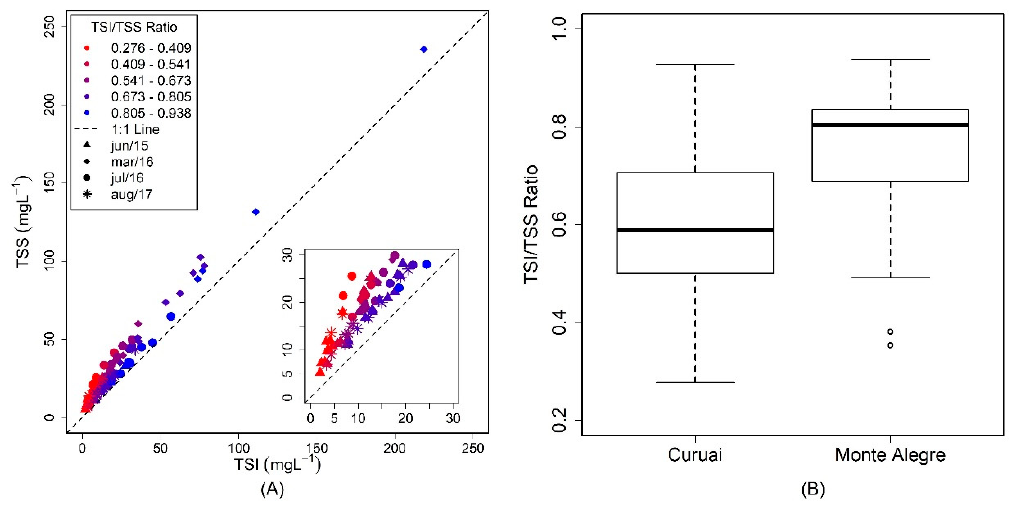
Figure 15. The TSI / TSS ratio for the All Dataset ( A ) and for the Curuai and Monte Alegre Lakes ( B ): The colors in the top-left legend of Figure 15A refers the TSI / TSS ratio and the symbols refer to the field campaigns. The highlighted box in the bottom-right of Figure 15A refers to the scatterplot of TSI per TSS concentration up to 30 mgL − 1 . Note the low values (red) of the TSI / TSS ratio at low sediments concentrations.